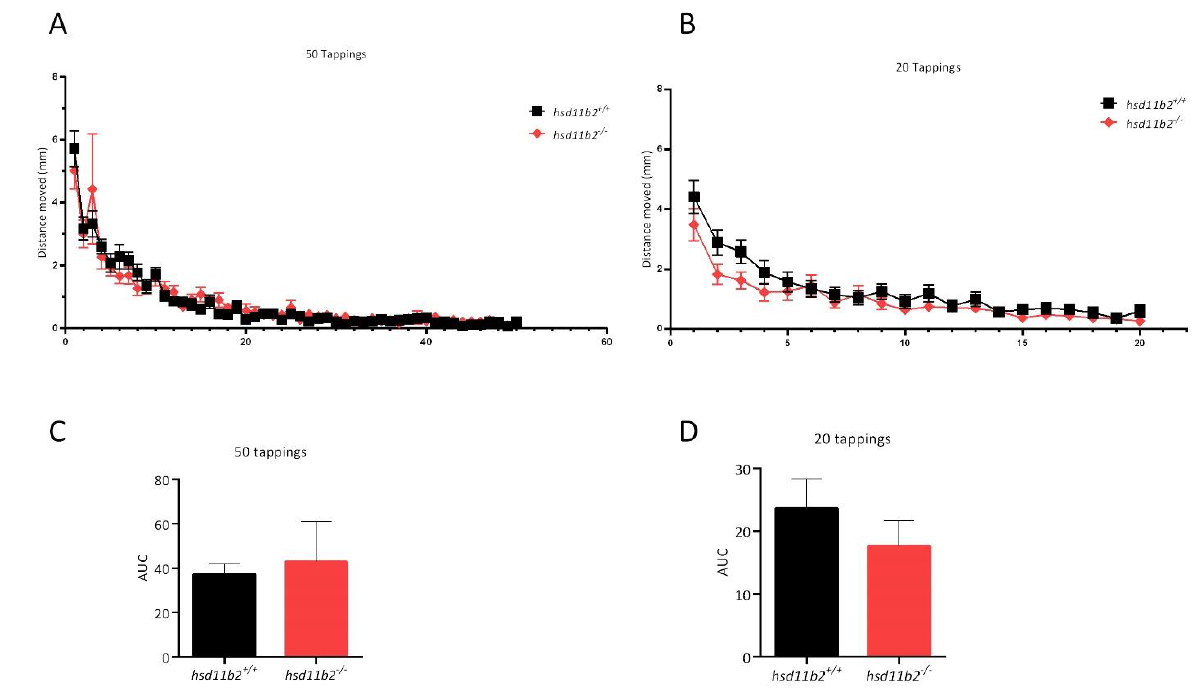
Figure 8. Effect of the VSRA on the escape response of zebrafish larvae. ( A ) Plots of mean distance moved ± SEM against 50 tapping stimuli at 1 s ISI. ( B ) Plots of mean distance moved ± SEM against a second sequence of 20 tapping stimuli at 1 s ISI (15 min after the 51st stimulus of the previous sequence). ( C , D ) Bar graphs of calculated AUC corresponding to the plots of graphs ( A , B ), respectively. Holm-Sidak comparison test was applied to identify groups that were significantly different.